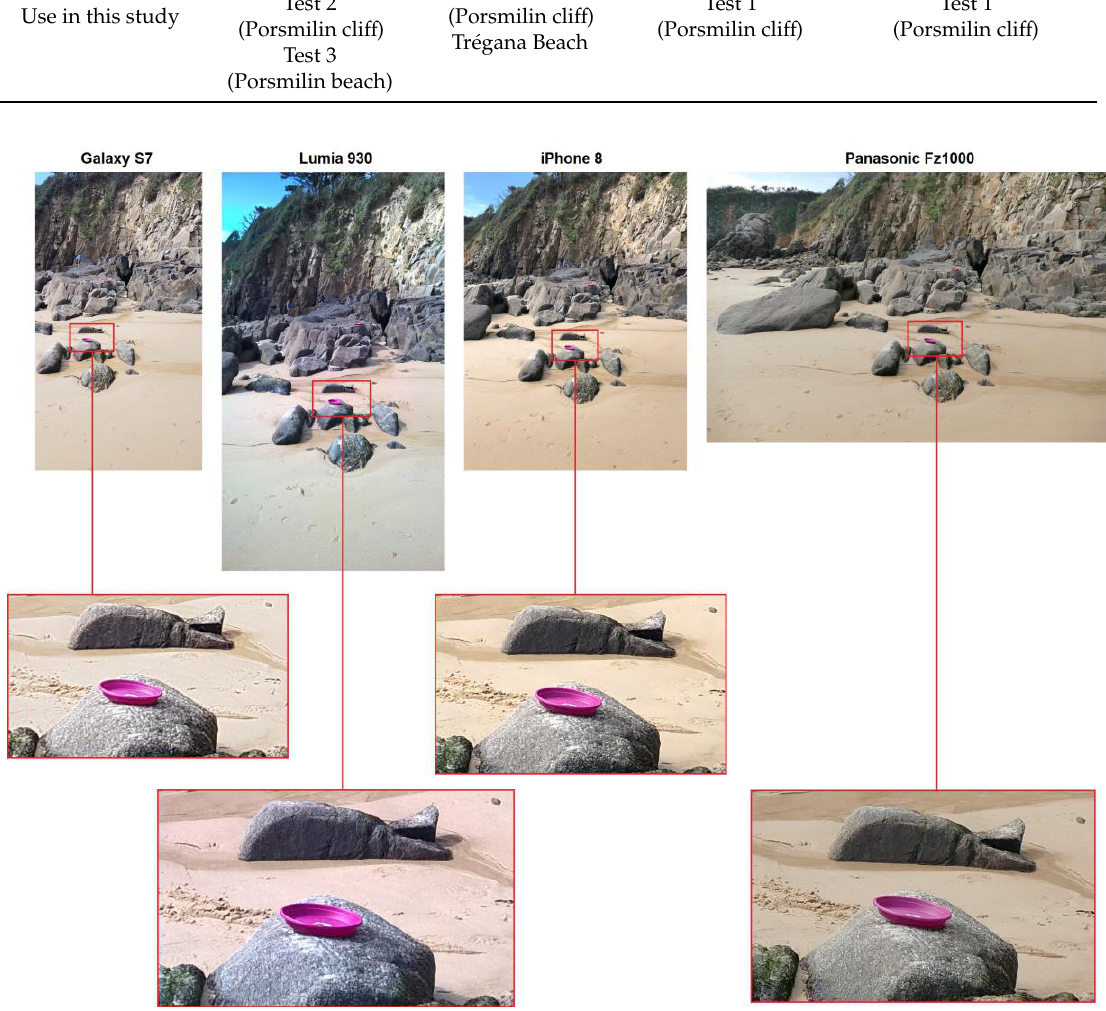
Figure 2. Comparison of photographs taken by the smartphones ( Galaxy S7 , Lumia 930 and iPhone 8 ) and the Fz1000 bridge camera. The size of the photographs is proportional to their native pixel